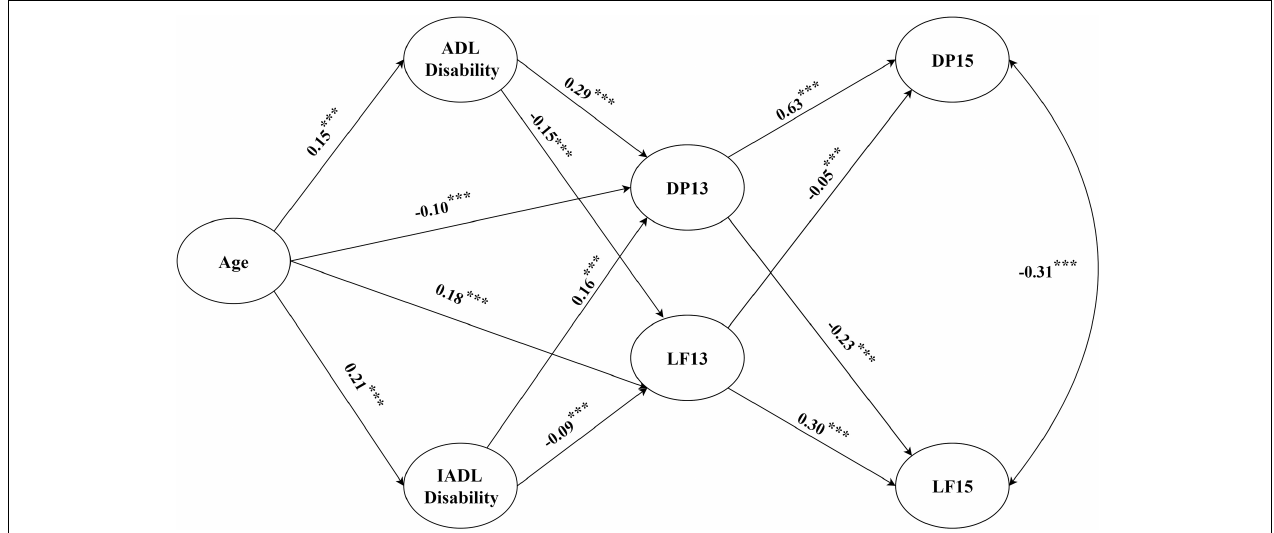
FIGURE 3 | Structural equation modeling. The model presented the direct and indirect effects between variables. Gender, as a control variable, is not shown in the figure. ADL, activities of daily living; IADL, instrumental activities of daily living; DP13, depression in 2013–2014; DP15, depression in 2015–2016; LF13, life satisfaction in 2013–2014; LF15, life satisfaction in 2015–2016. *** p < 0.001.